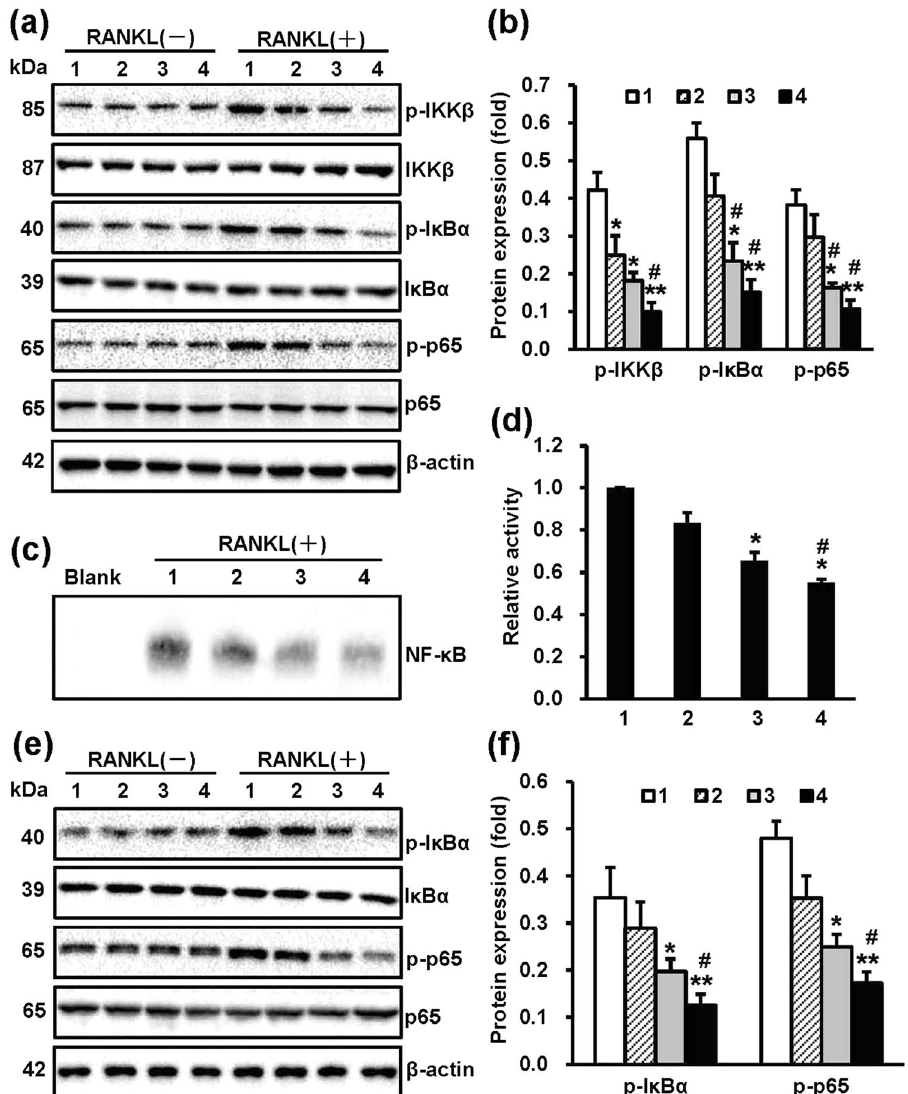
Figure 6. NT-Sr inhibit RANKL-induced NF- κ B activation. After RAW264.7 cells ( a , b ) and mouse BMMCs ( e , f ) were cultured on different samples for 3 d, the cells were stimulated with or without 100 ng/mL RANKL for 30 min, and the total proteins were extracted for western blot analysis. The expression of proteins in the NF- κ B pathway and the levels of p-IKK β , p-I κ B α , and p-NF- κ Bp65 were detected. Antibodies against β -actin, total IKK β , I κ B α , and NF- κ Bp65 were used as loading controls. A quantitative analysis of the band densities was performed, and the band densities were normalised to the loading controls. RAW264.7 cells ( c , d ) were cultured on different samples for 3 d and stimulated with 100 ng/mL RANKL for 30 min. The nuclear extracts were then collected, and the DNA-binding activity of NF- κ B was detected by electrophoretic mobility shift assay (EMSA). A quantitative analysis of the band densities was performed, and the band densities were normalised to the loading controls. Full-length blots are presented in Supplementary Figure 3. p-p65 and p65 represent p-NF- κ Bp65 and NF- κ Bp65, respectively; and the numbers 1, 2, 3 and 4 in the figure represent Ti, TiO Sr1h and NT-Sr3h, respectively. * , ** p < 0.05 and 0.01, respectively, compared with the Ti group, and # p < 0.05 compared with TiO 2 -NTs. At least three independent experiments were analysed, and the data are presented as the means ±